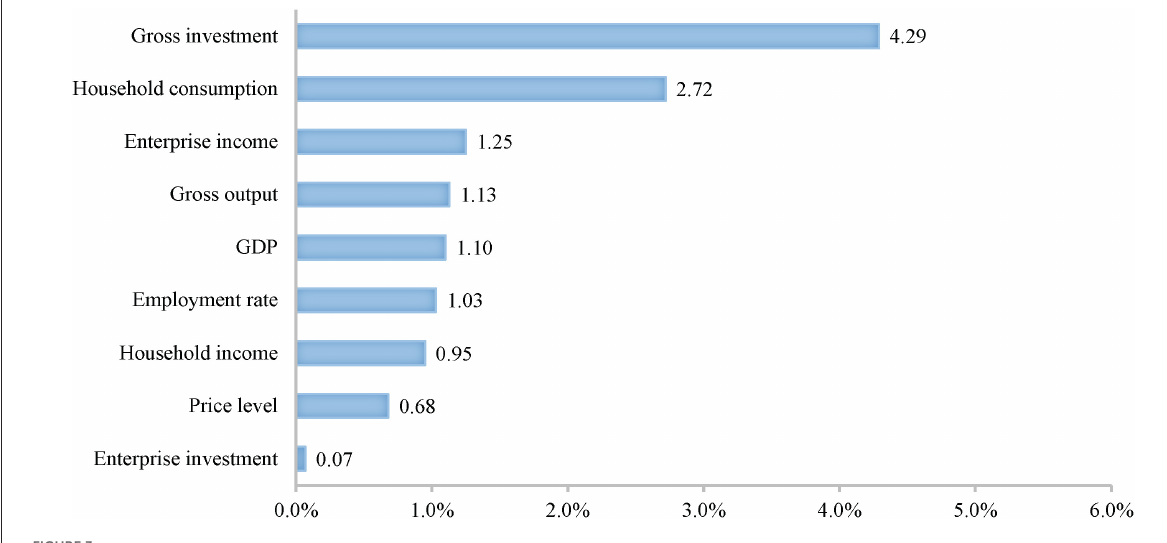
FIGURE3 The total effects of fiscal policies on macro-economy (Unit: %).